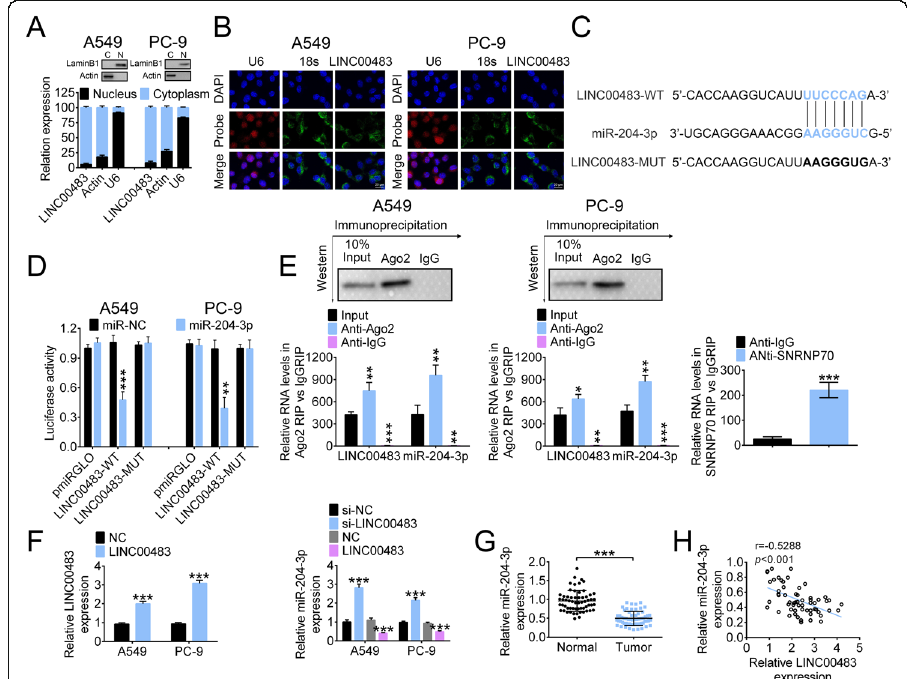
Fig. 3 LINC00483 acts as a sponge of miR-204-3p. a The expression of LINC00483 in the cytoplasm and nucleus of A549 and PC-9 cells was measured using real-time PCR. b Fluorescence in situ hybridization assay was performed to determine the subcellular localization of LINC00483. c and d The correlation between LINC00483 ( c ) and miR-204-3p ( d ) was validated using the dual-luciferase assay. e LINC00483 and miR-204-3p were enriched via RNA immunoprecipitation with Ago2 antibody. SNRNP70 was used as a control. f The RNA levels of LINC00483 and miR-204-3p after LINC00483 overexpression were measured using real-time PCR. g and h The expression of miR-204-3p in tumor and normal tissues was measured using real-time PCR, and a negative correlation between LINC00483 level and miR-204-3p expression was observed, ** p < 0.01; *** p <